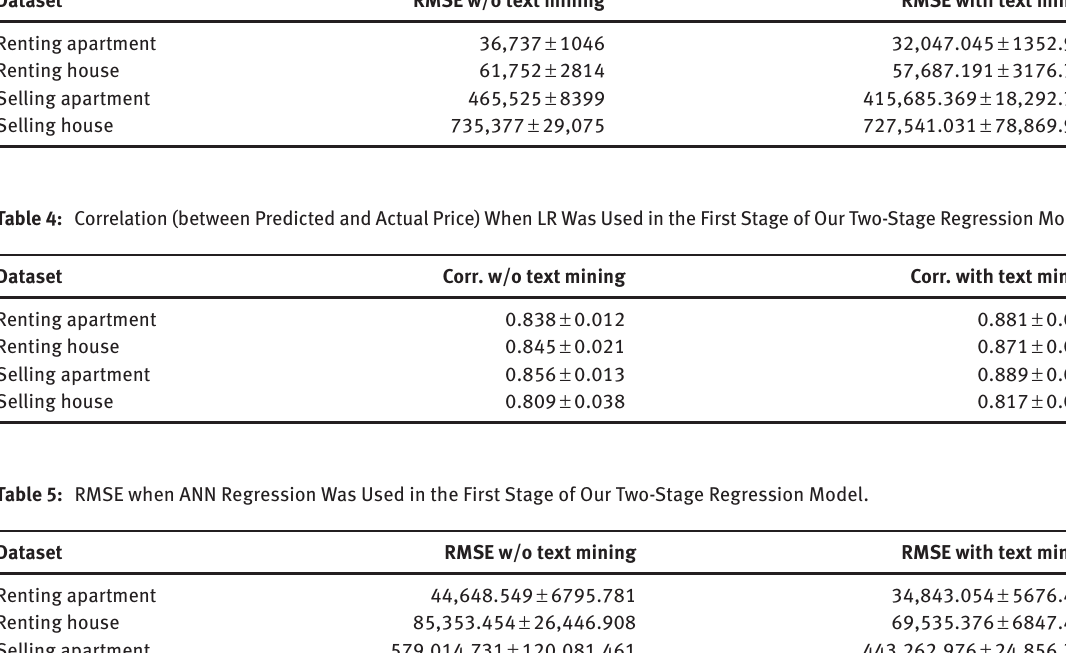
Table 3: RMSE When LR Was Used in Stage 1 of Our Two-Stage Regression Model. Dataset